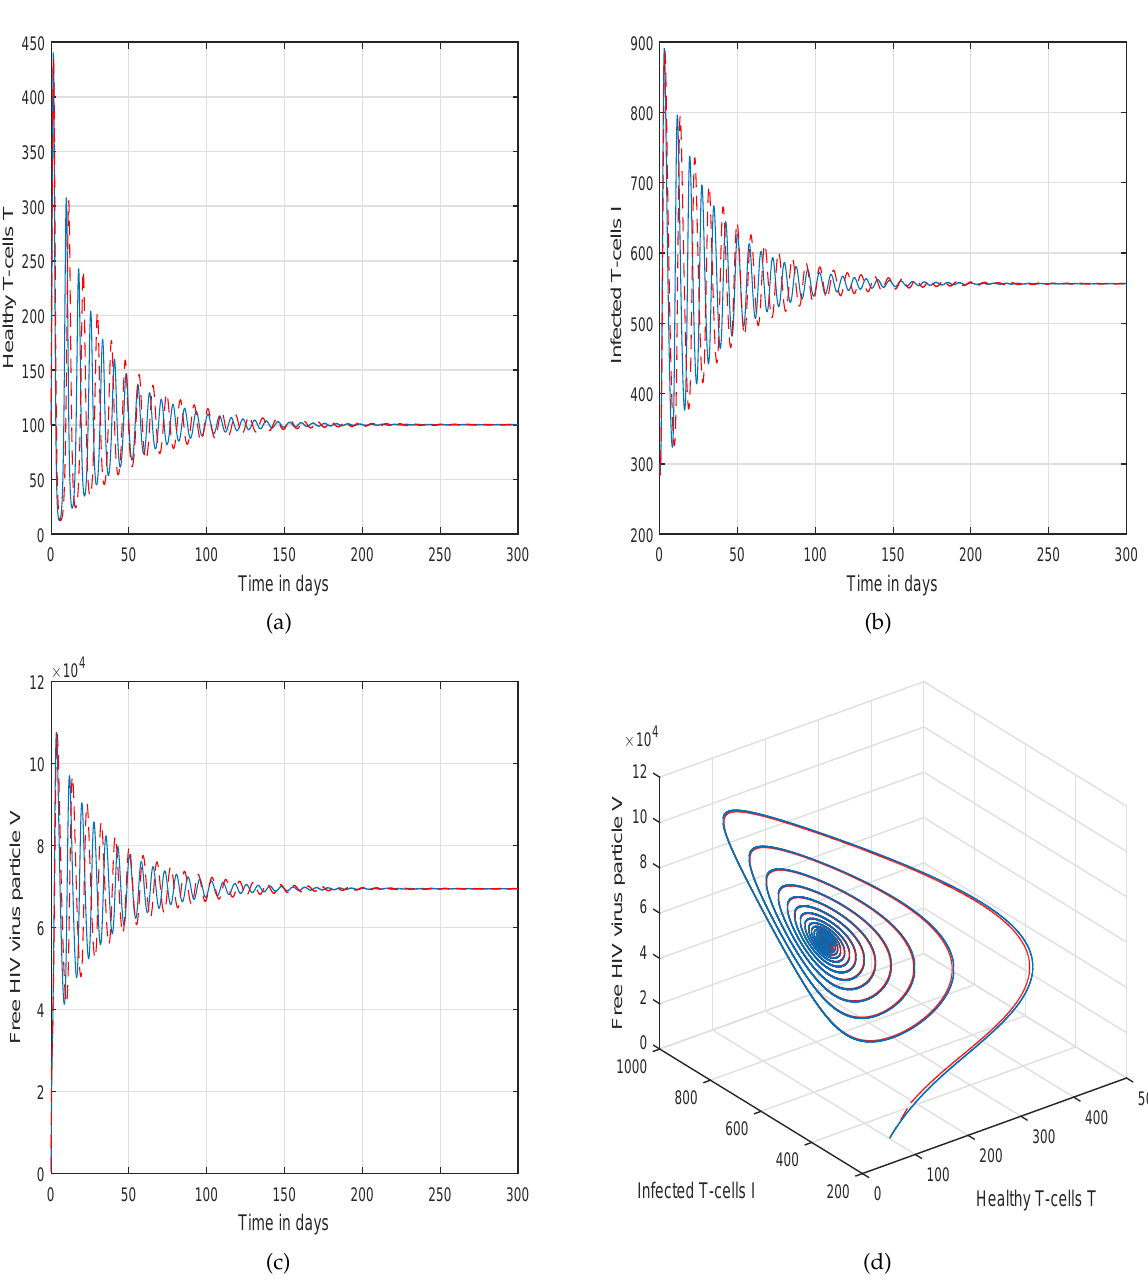
Figure 2. Illustration of the solution pathway of ( a ) healthy CD4 + T-cells, ( b ) infected CD4 + T-cells, ( c ) free HIV virus particles and ( d ) chaotic behavior of the proposed fractional model (2) of HIV infection with fractional-order ϑ =